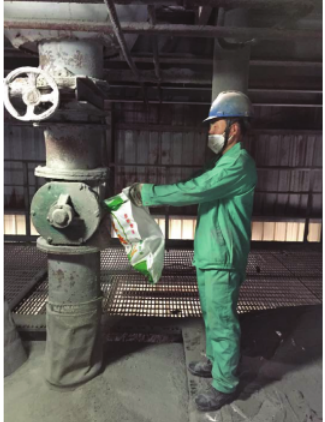
Figure 1: MSWI fly ash sample